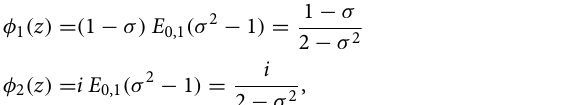
2 (dashed line) for the linear PT case φ 2 ( z ) | | 0.25, σ 0 , ( e ) α 1, σ 0.5 , ( f ) α = = = = 0.8, σ 1.1 = =